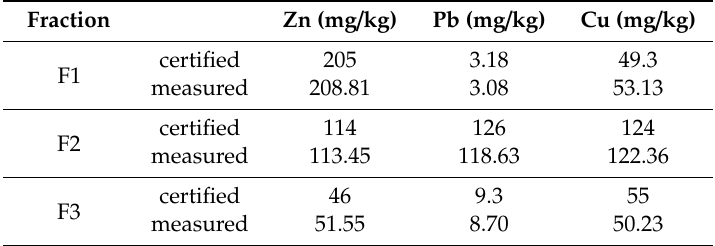
Table 4. Comparison of the results of our laboratory and certified values on BCR 701.